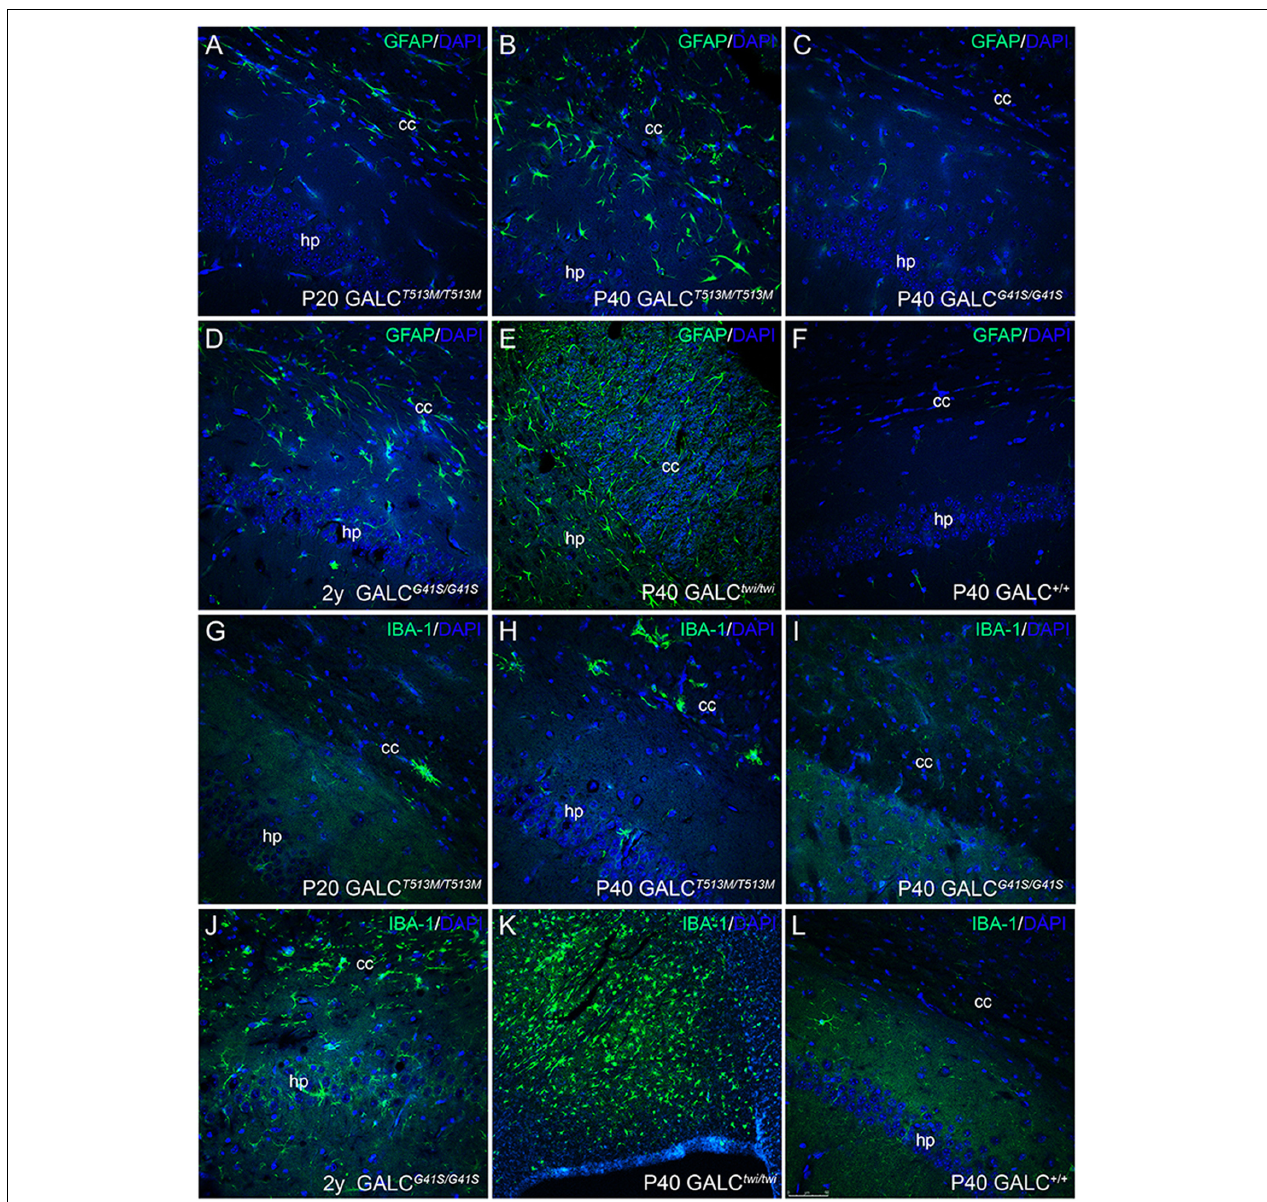
FIGURE 9 | Inflammatory responses in the brain of GALC T 513 M / T 513 M and GALC G 41 S / G 41 S mice. Immunohistochemistry using anti-GFAP (A–F) and anti-IBA-1 (G–L) antibodies detected gliotic responses (in green) in the corpus callosum and hippocampus of GALC T 513 M / T 513 M and GALC G 41 S / G 41 S mice. Confocal microscopy showed that GFAP+ astroglial cells were comparable to those observed in TWI mice (E) . In contrast, IBA-1+ cells were less abundant in either mutant than in TWI mice (K) . Bar = 50 µ m, except in panel (K) , where is 100 µ